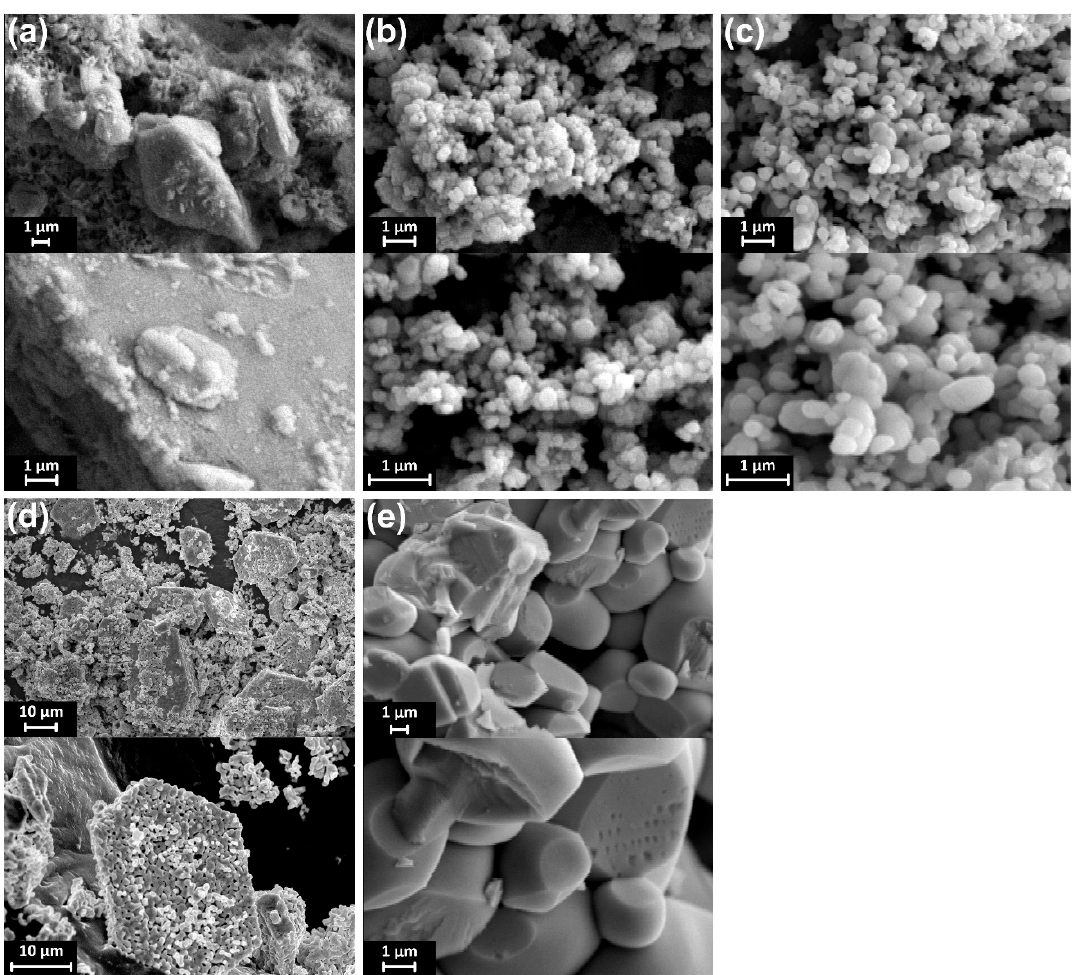
Figure 6. SEM images of the BiVO4 amorphous ( a ) and sulfate-modified BiVO 4 annealed at 400 ◦ C ( b ), 500 ◦ C ( c ), 600 ◦ C ( d ), and 700 ◦ C ( e ).